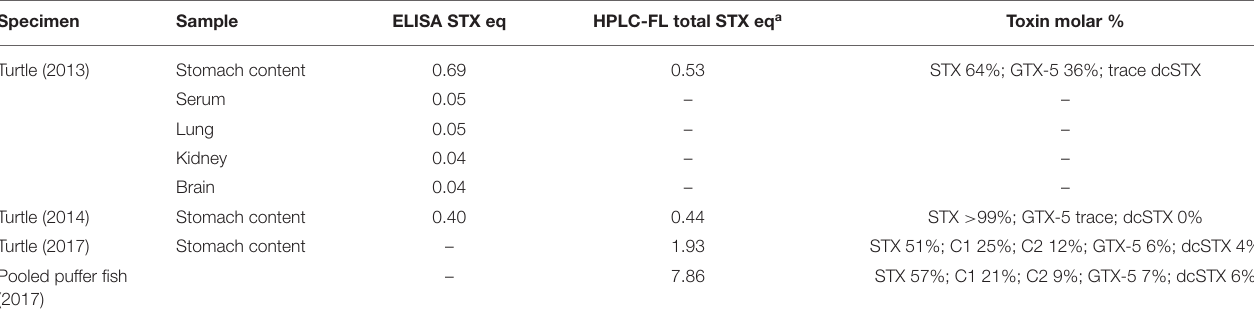
TABLE 2 | Results of high-performance liquid chromatography with fluorescence detection (HPLC-FL) analyses of samples from stranded green sea turtles ( Chelonia mydas ) collected in 2013, 2014, and 2017 and puffer fish ( Canthigaster rostrata ) from 2017.